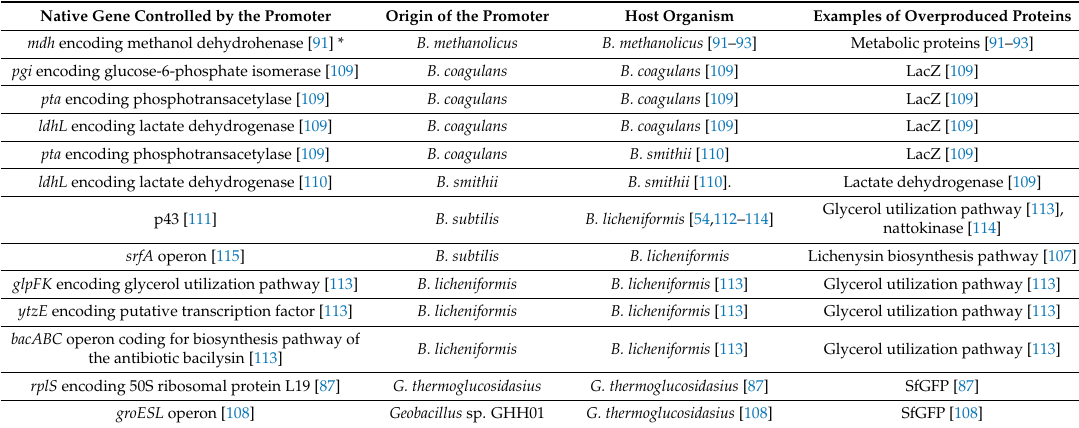
Table 4. Constitutive promoters used in thermophilic